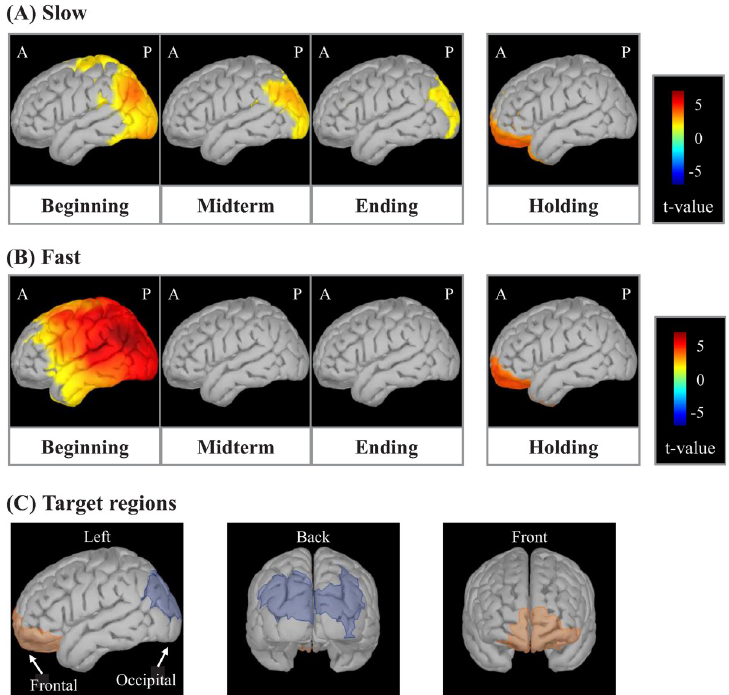
Fig 4. Cortical t-maps showing regions of significant standardized cortical theta activity according to task period/ sub-period. Occipital-theta activity is observed throughout all sub-periods in the memory item presentation (MIP) period in the slow task (A), while prominent only in the beginning sub-period in the fast task (B). Frontal-theta is significantly active during the holding period in both tasks. The occipital and frontal regions were selected as target regions due to their significantly positive standardized cortical theta activities in both tasks during the MIP and holding periods, respectively (C).